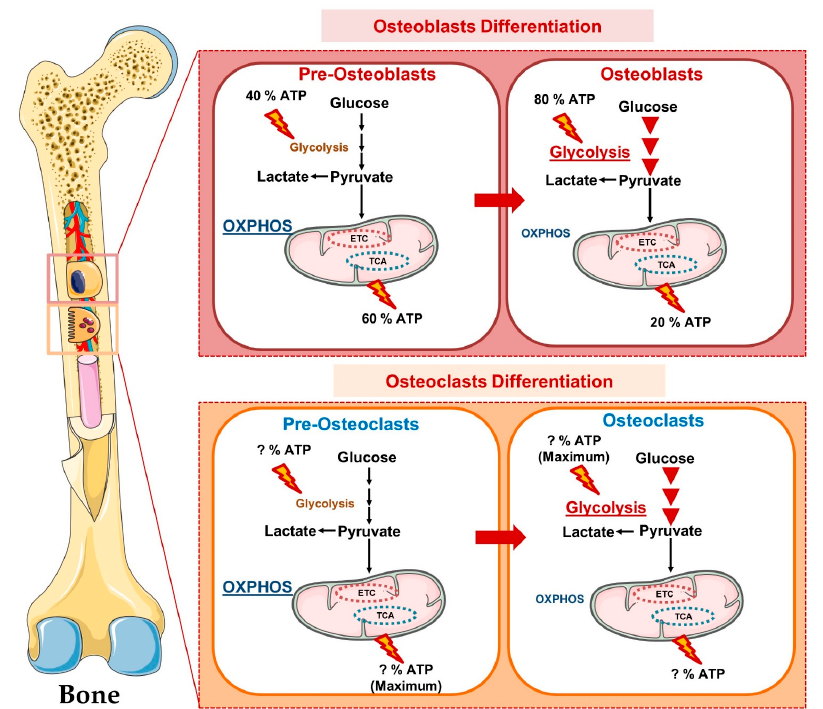
Figure 6. Osteometabolism (Metabolism of Bone Cells): In precursors form, osteoclast and osteoblast cells obtain maximum energy from oxidative phosphorylation whereas in mature form these bone cells obtain energy predominantly from glycolysis.